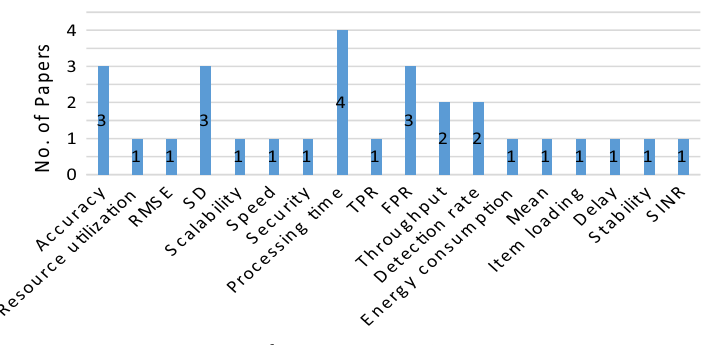
Fig. 3 Chart based on the analysis of the performance metrics